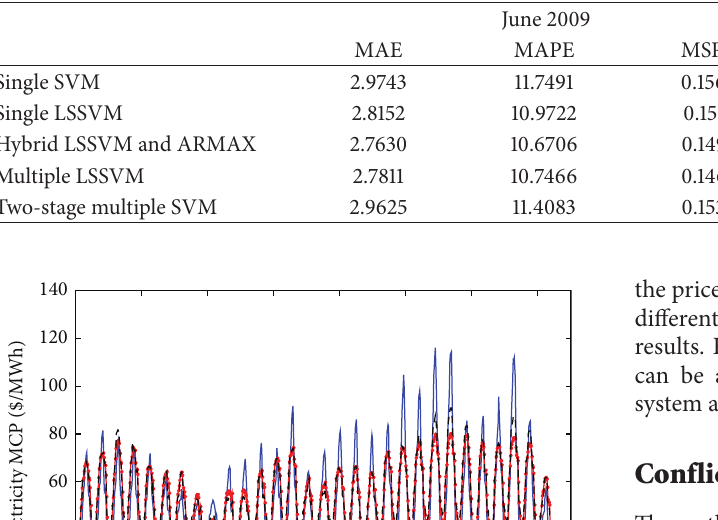
Table 8: Performance evaluation results between the proposed two-stage multiple SVM model and other forecasting models.